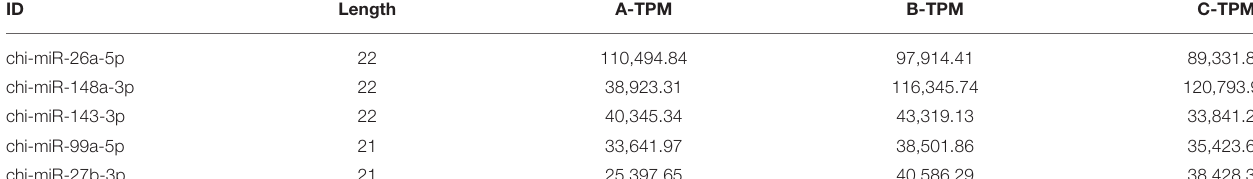
TABLE 4 | The Expression level of the top 5 miRNAs with highest expression levels in different groups.